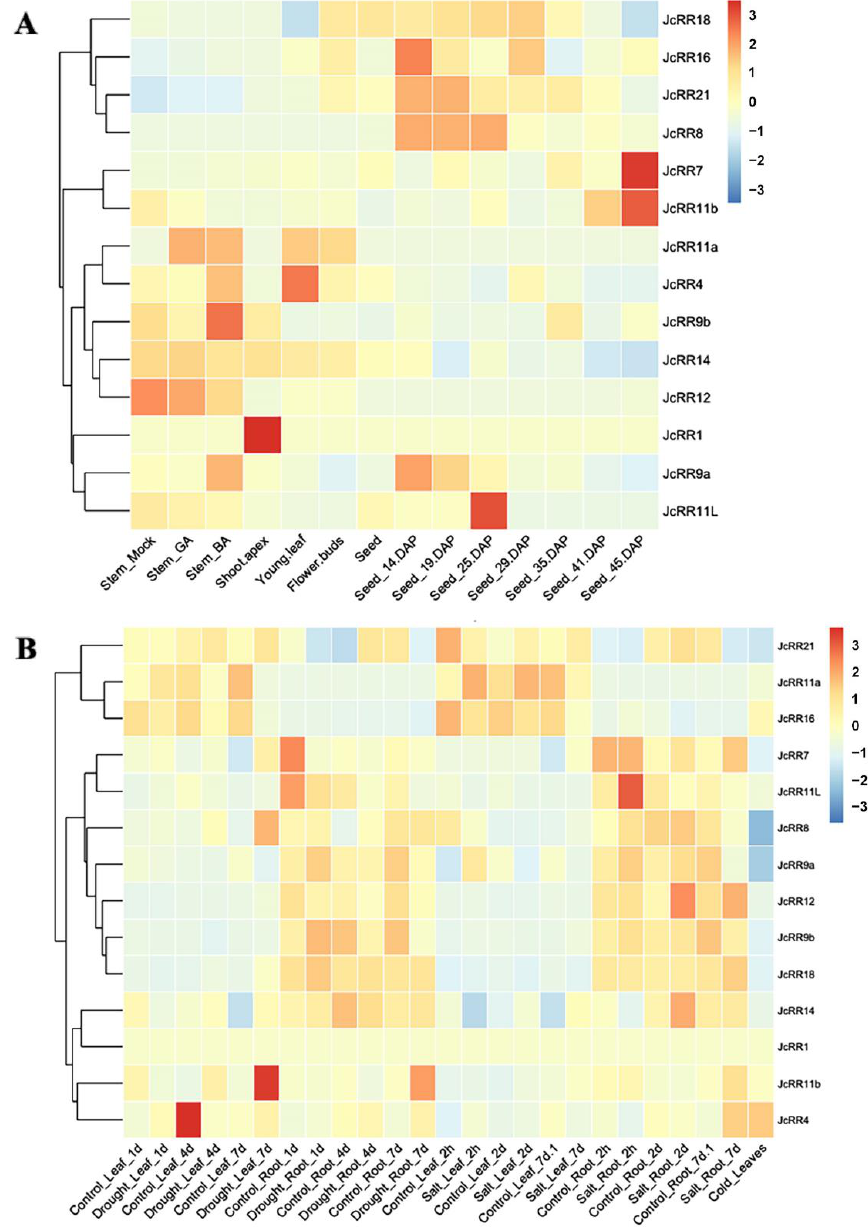
Figure 7. Expression patterns of JcRR s, as revealed by RNA sequencing analysis. ( A ) Expression in response to 6-benzylaminopurine (6-BA) or GA 3 treatment, in different tissues, and in seeds at different developmental stages after pollination. ( B ) Leaves and roots under different stresses. The genome-wide expression profiles of JcRRs are shown on a heatmap using the log 2 (reads per kilobase per million mapped reads (RPKM)) value, and −3.00 to 3.00 were artificially set with the color scale limits according to the normalized value. The color scale shows increasing expression levels from blue to red.